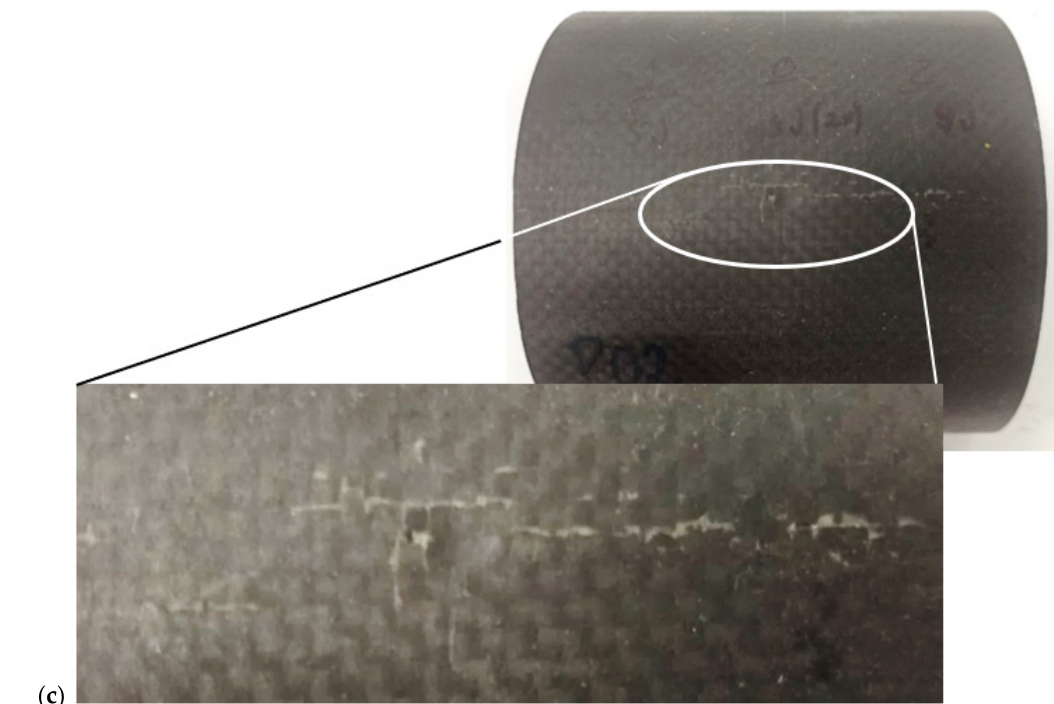
Figure 8. Failure mechanisms after impact for shells with: ( a ) four layers; ( b ) six layers; ( c ) eight layers.